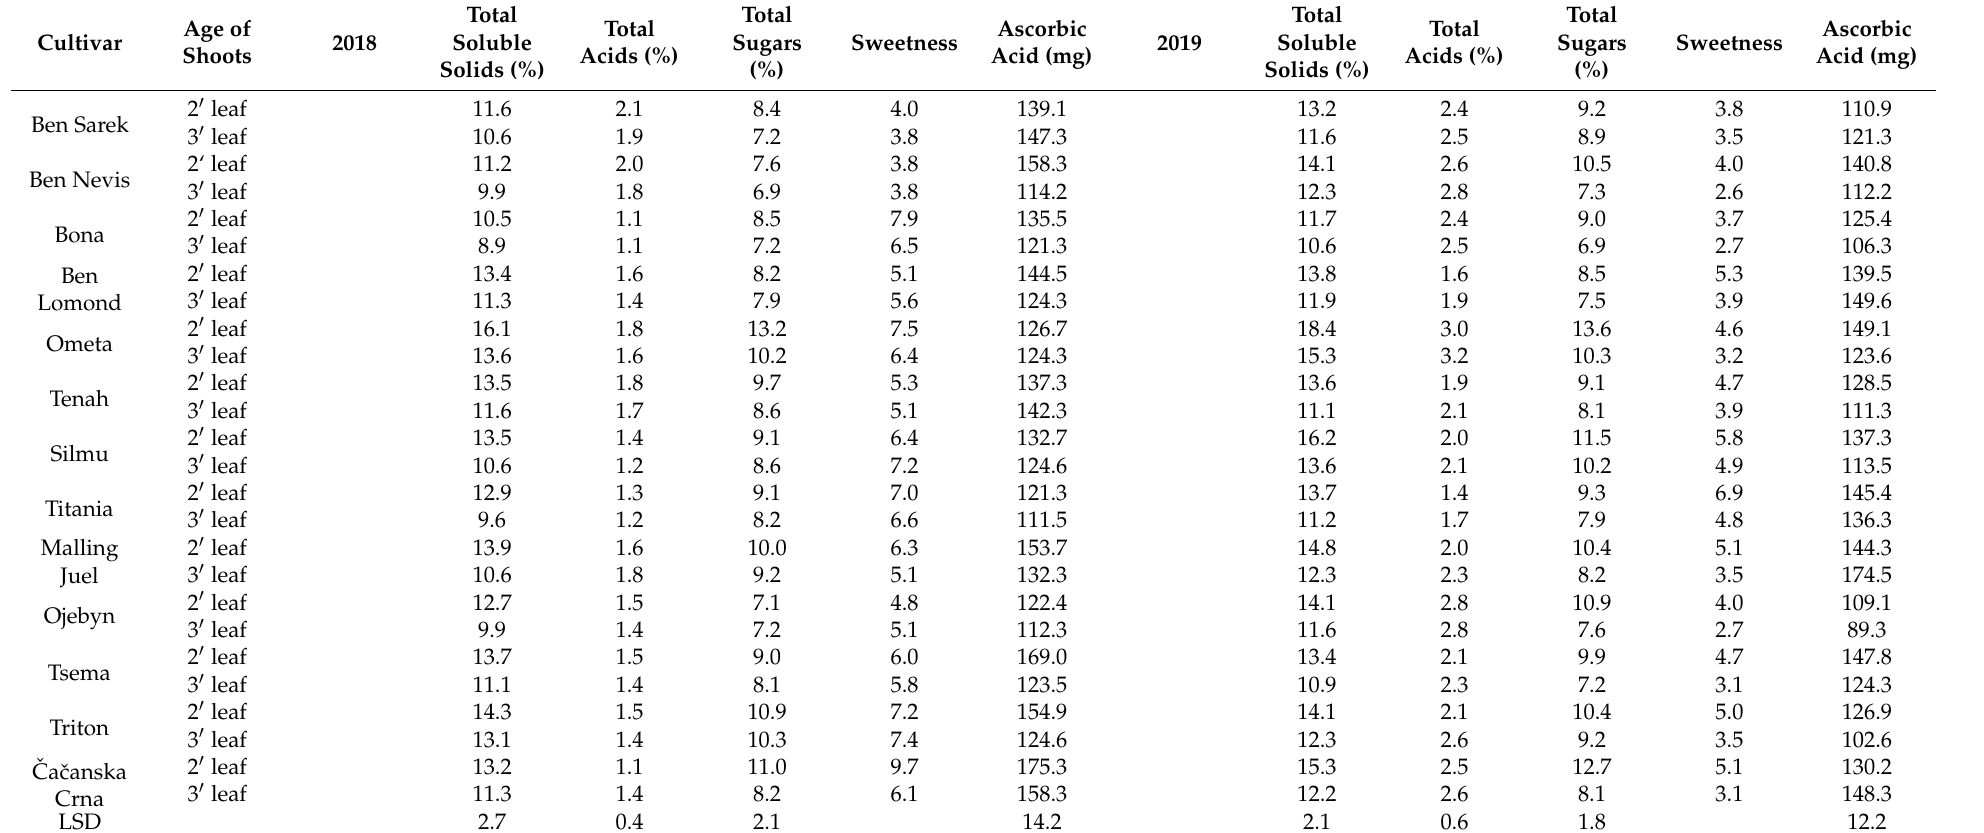
Table 3. Contents of primary metabolites of berries of 13 studied black currant cultivars in 2018 and 2019 year.